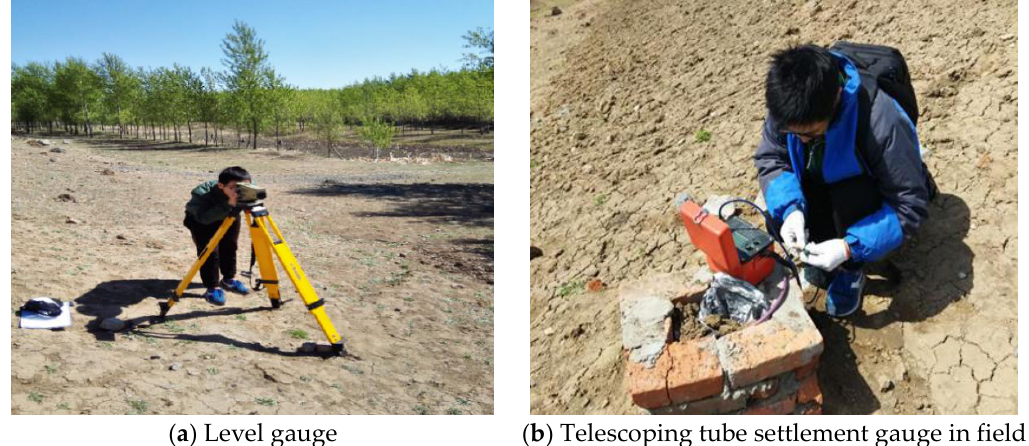
Figure 9. Field monitoring.